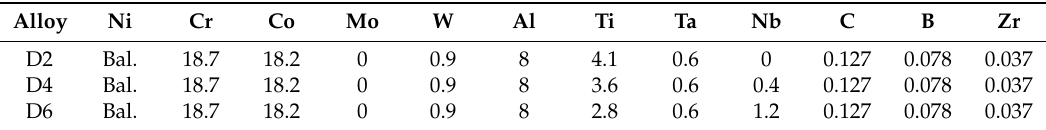
Table 2. The nominal alloy compositions in this study (atom